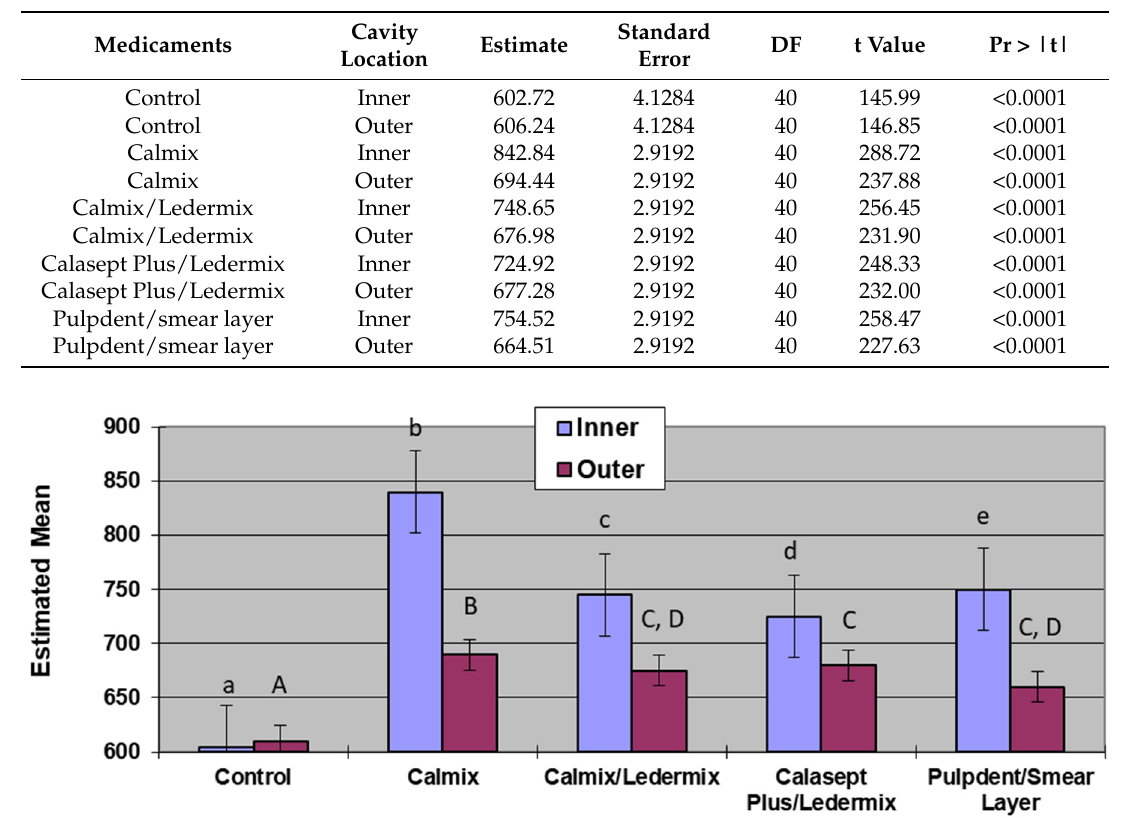
Table 2. Area under the curve responses and statistical comparisons between groups.